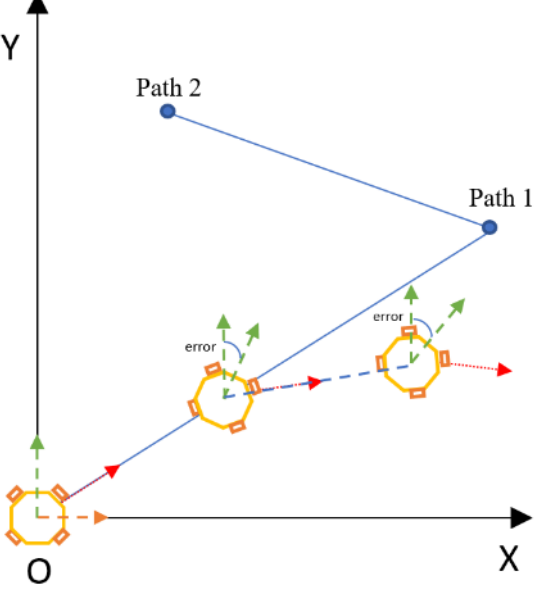
Figure 7. Illustration of movement error caused by the change of robot